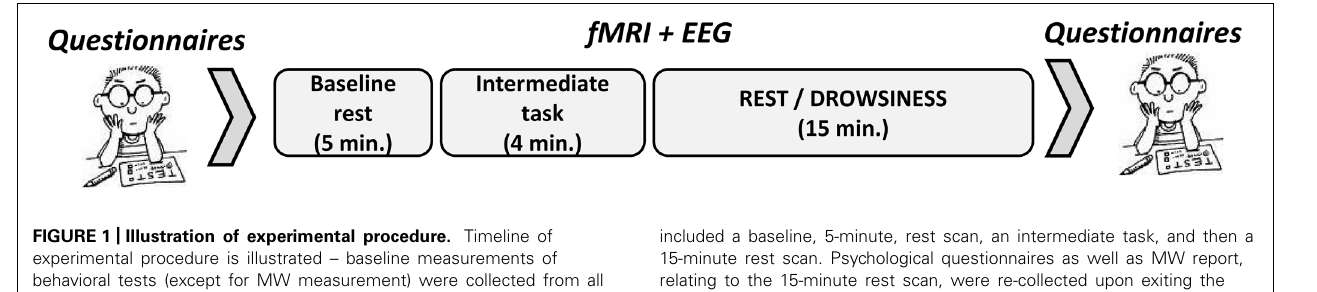
included a baseline, 5-minute, rest scan, an intermediate task, and then a 15-minute rest scan. Psychological questionnaires as well as MW report, relating to the 15-minute rest scan, were re-collected upon exiting the MRI